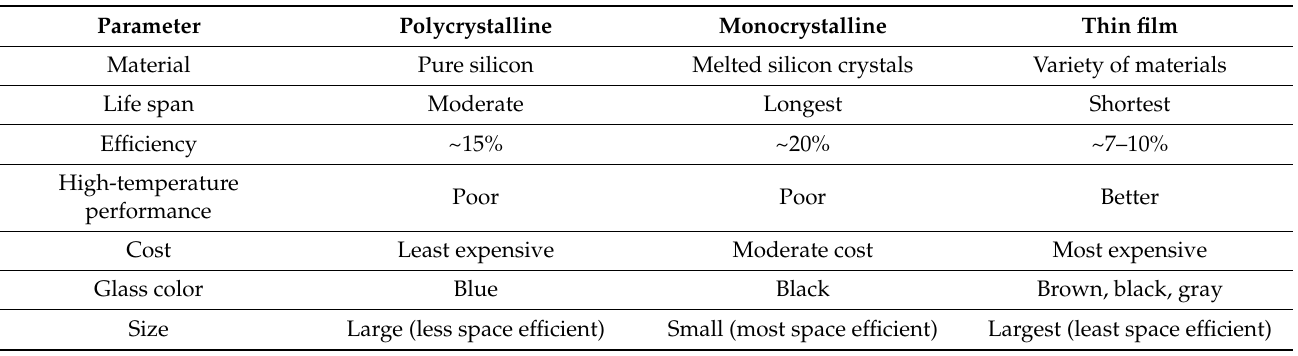
Table 3. Types of PV solar panels.